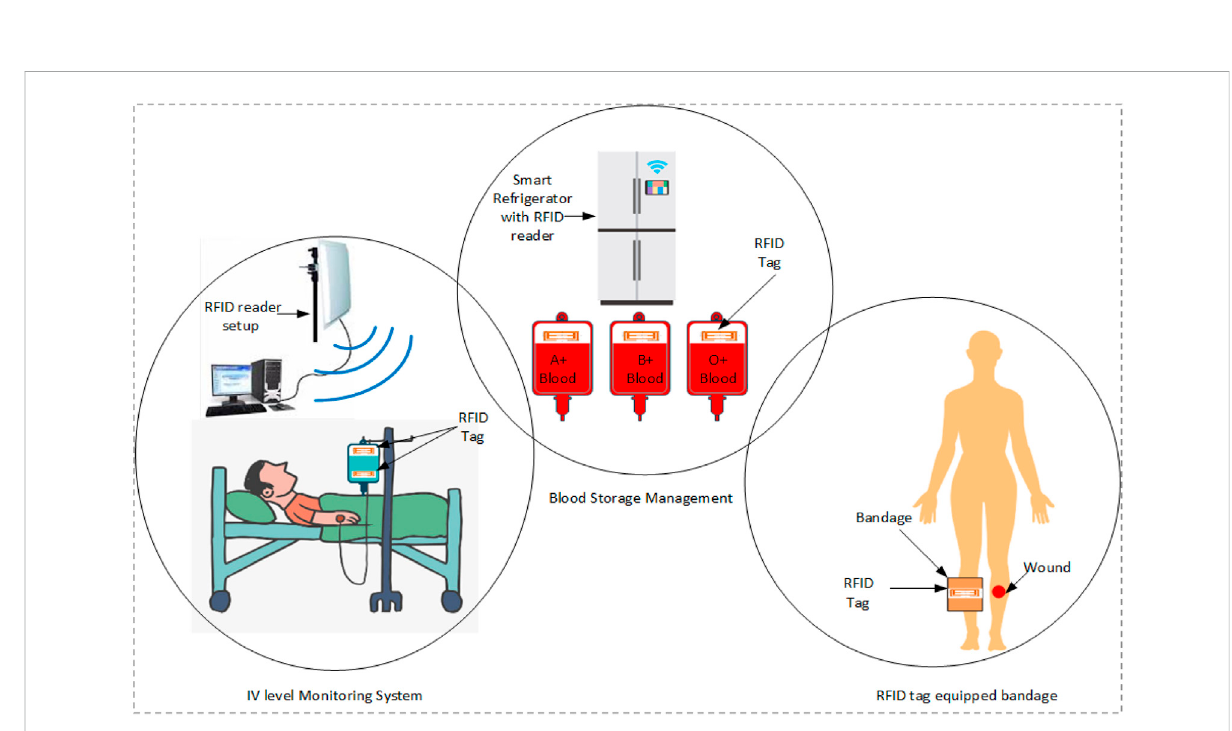
FIGURE 8 Schematic diagram for the potential use of the RFID-IoT tag in healthcare applications (Sharif et al., 2019e).